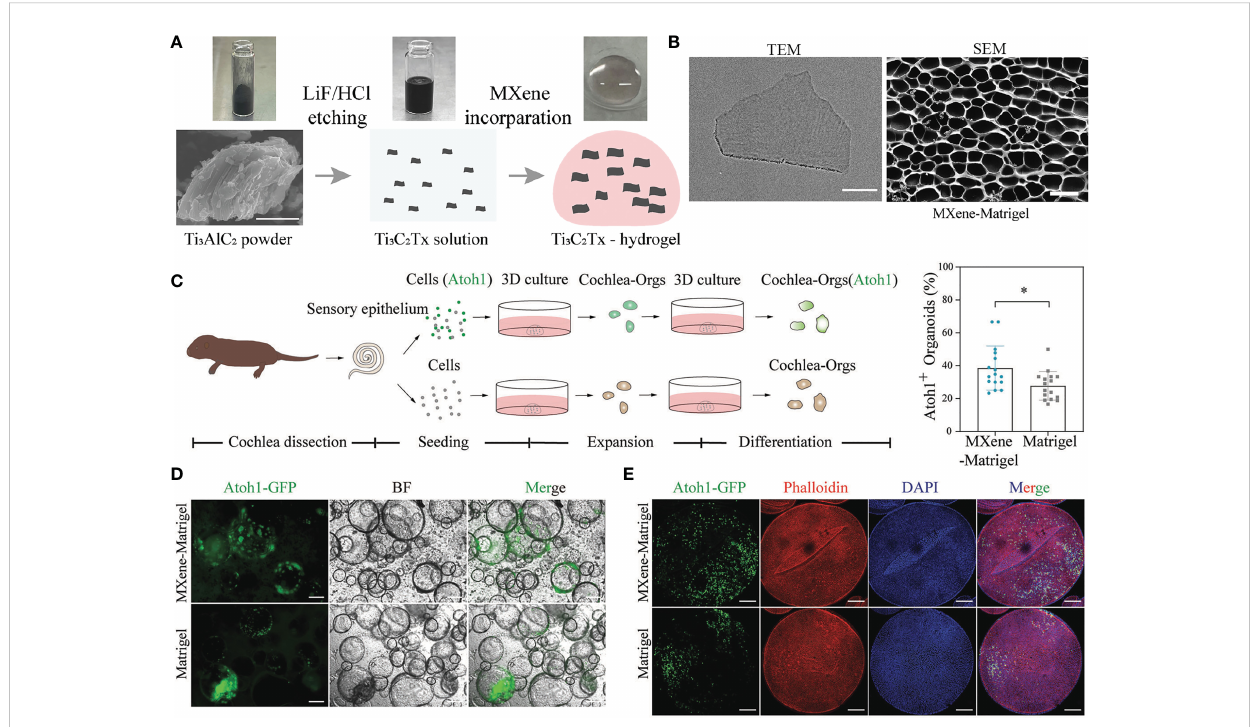
FIGURE 3 Ti 3 C 2 T x MXene-Matrigel hydrogel potentiated hair cells formation of Cochlea organoids. (A) Schematic diagram of the preparation of Ti 3 C 2 T x MXene- Matrigel. Appropriate amount of Ti 3 C 2 T x MXene solution was mixed with Matrigel, and the incorporating hydrogel was solidi fi ed at 37°C. (B) Representative TEM (bar: 200 nm) or SEM (50 m m) image of the Ti 3 C 2 T x MXene nanosheets. (C) Overview of the generation of cochlea hair cells through the differentiation of Cochlea organoids. (D) BF and green fl uorescent (Atoh1-GFP) images of Cochlea-Orgs after 20 days of